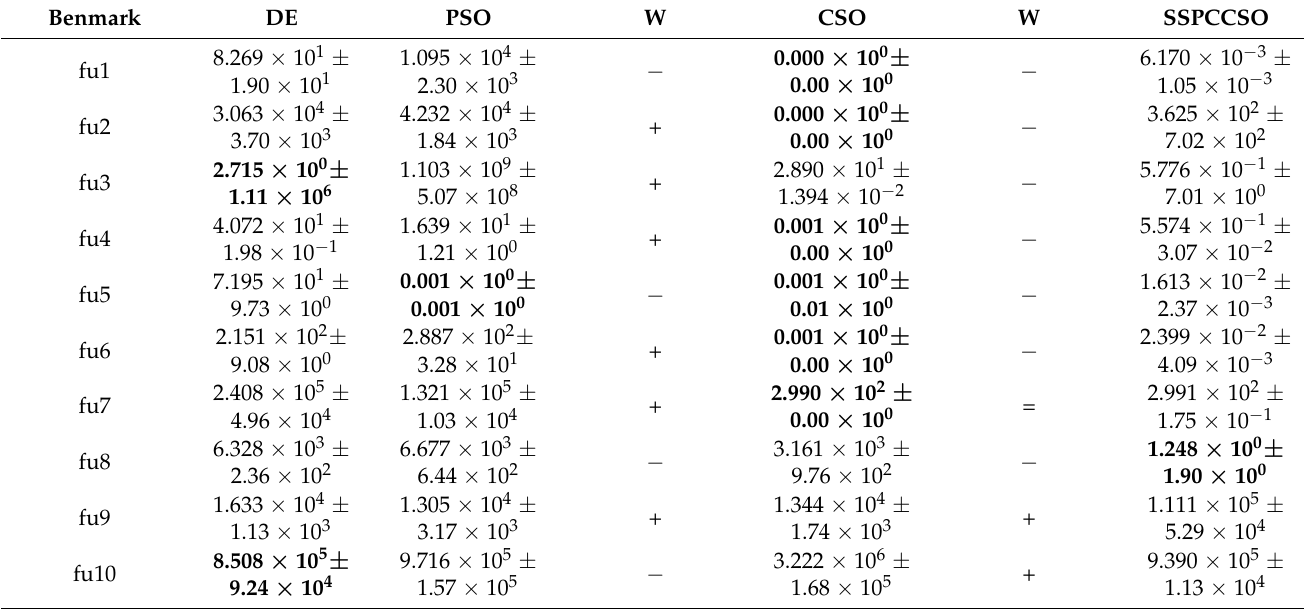
Table 4. Comparison among SSPCCSO, CSO, PSO and